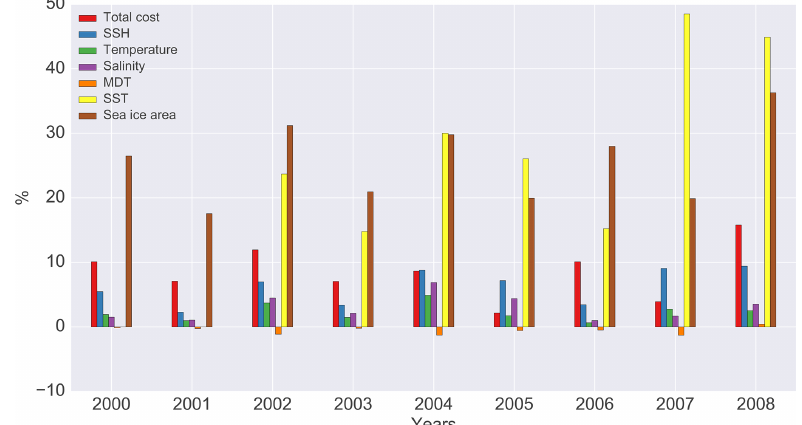
Figure 2. Total cost reduction and individual contributions to the reduction from different assimilated variables. During the first 2 years SST assimilation is not performed (no